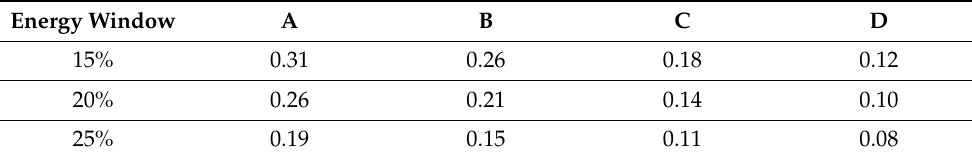
Table 1. Values of defect contrast at the anterior location in myocardial SPECT image in different positions of the phantom for three energy